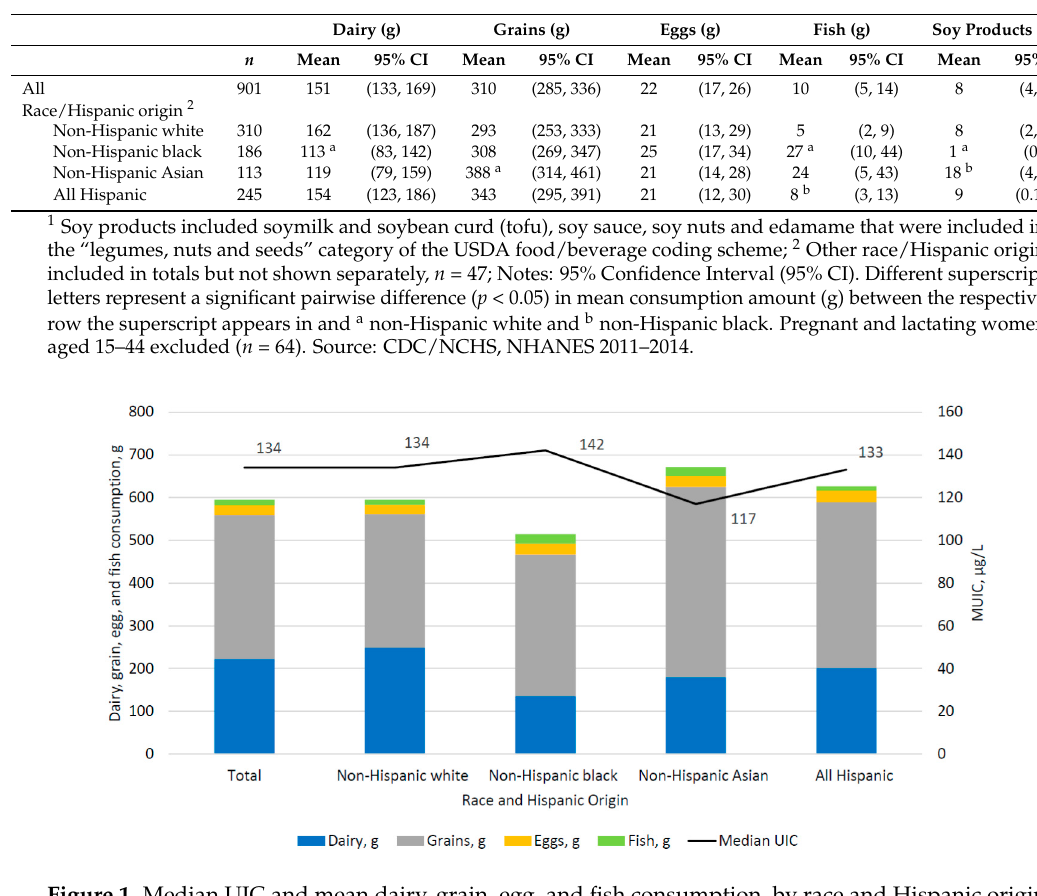
Figure 1. Median UIC and mean dairy, grain, egg, and fish consumption, by race and Hispanic origin among children and adults aged 6 and over, NHANES 2011–2014.